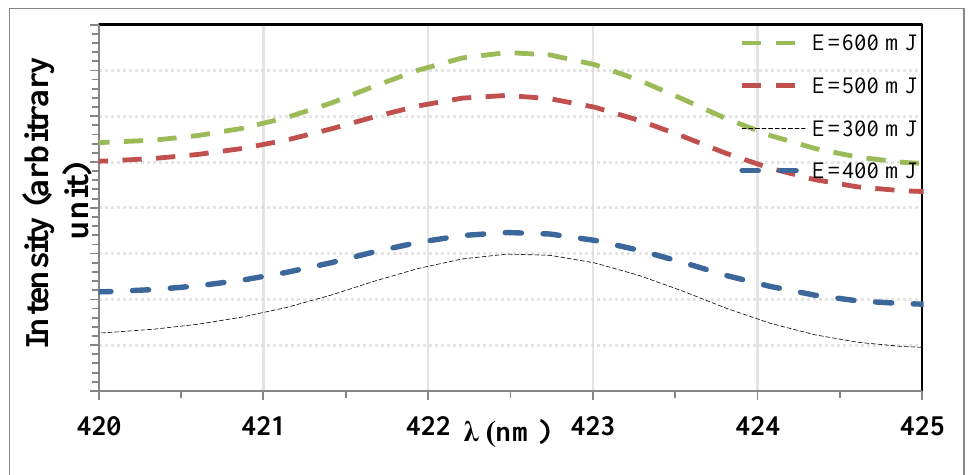
Figure 6: The Stark distribution of the Indian costus target for different wavelengths at different Laser Energies.